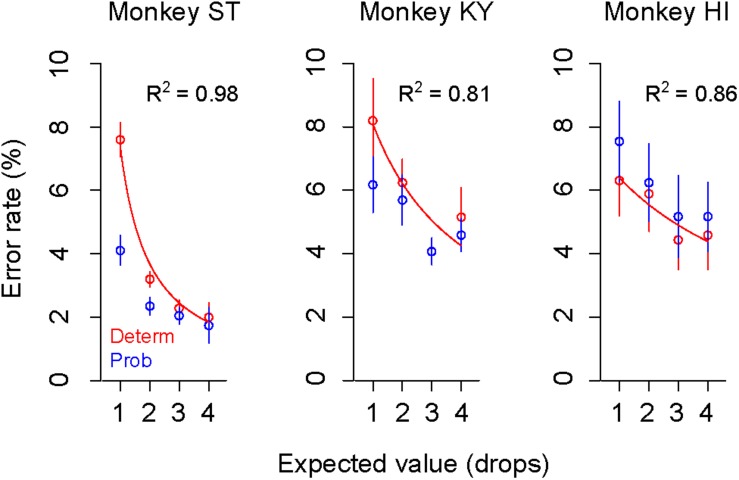
Change of error rate by reward-expected value and risk. Error rates (mean ± SEM) in deterministic (red) and probabilistic trials (blue) are plotted as a function of expected values for monkey ST (left), KY (center), and HI (right). The best-fit inverse function (red) is superimposed on the plots (ST: c = 7.3, b = –1.8; KY: c = 26.9, b = 2.3, HI: c = 41.9, b = 5.6) with the goodness of fit (R2) on each panel.